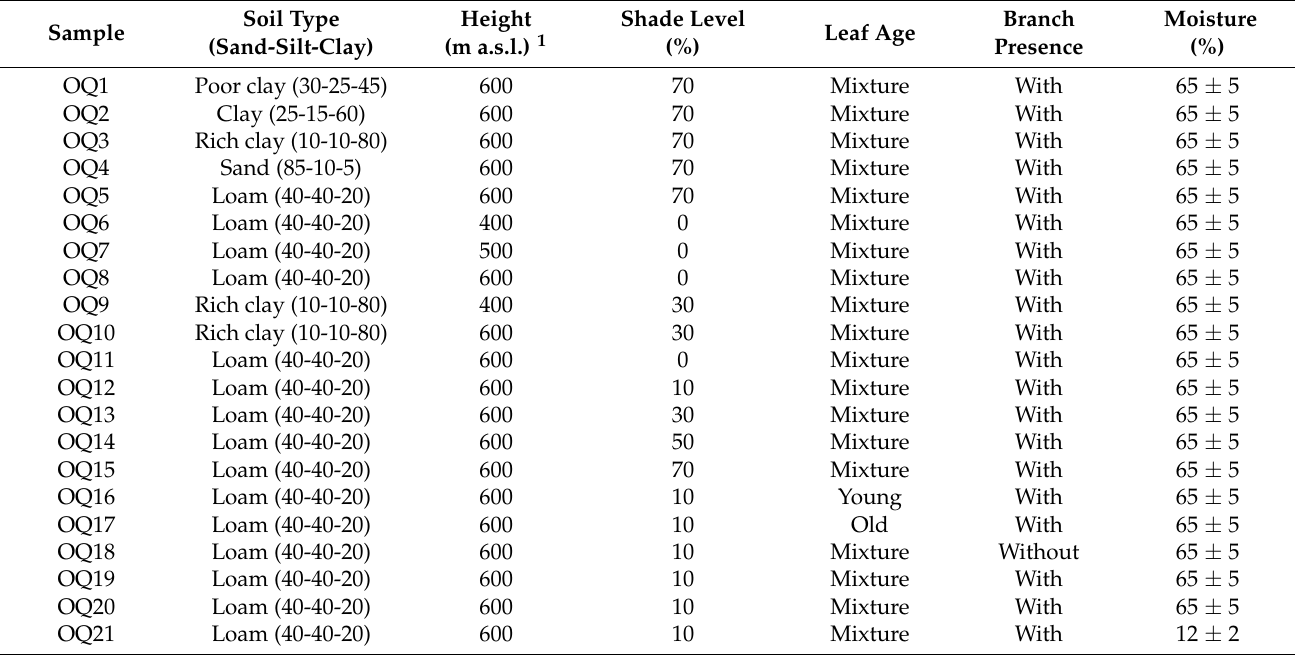
Table 1. Environmental conditions of collection and characteristics of ishpingo ( Ocotea quixos ) leaves of the samples studied.